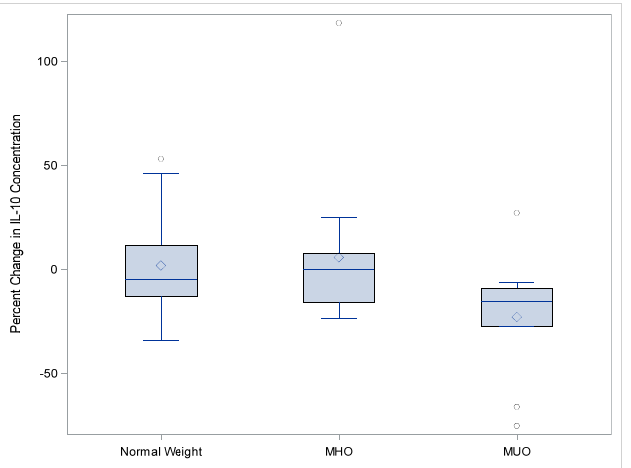
Figure 3. IL-10 percent change in concentration from baseline to 1 month post-influenza vaccination.